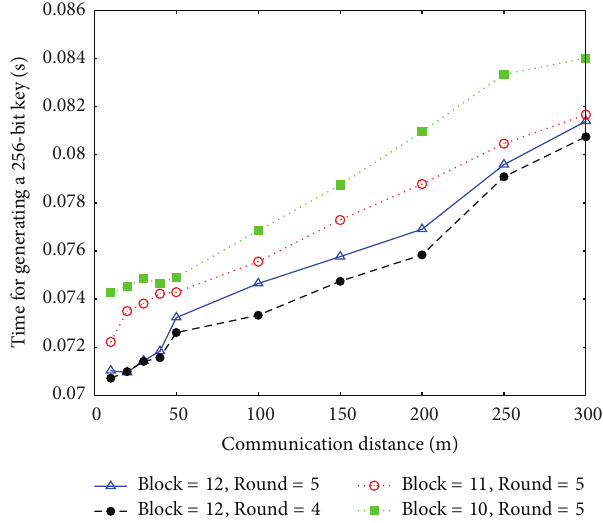
Figure 9: Efficiency of key generation under different communica- tion distances. The measured time is for generating a 256-bit key.